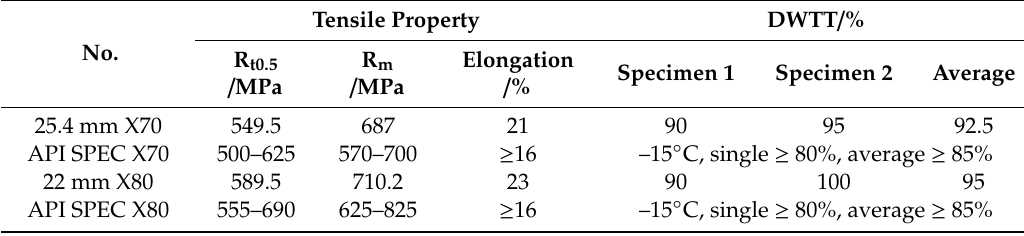
Table 3. Typical mechanical properties of 25.4 mm X70 and 22 mm X80 pipeline strip processed by UFC.